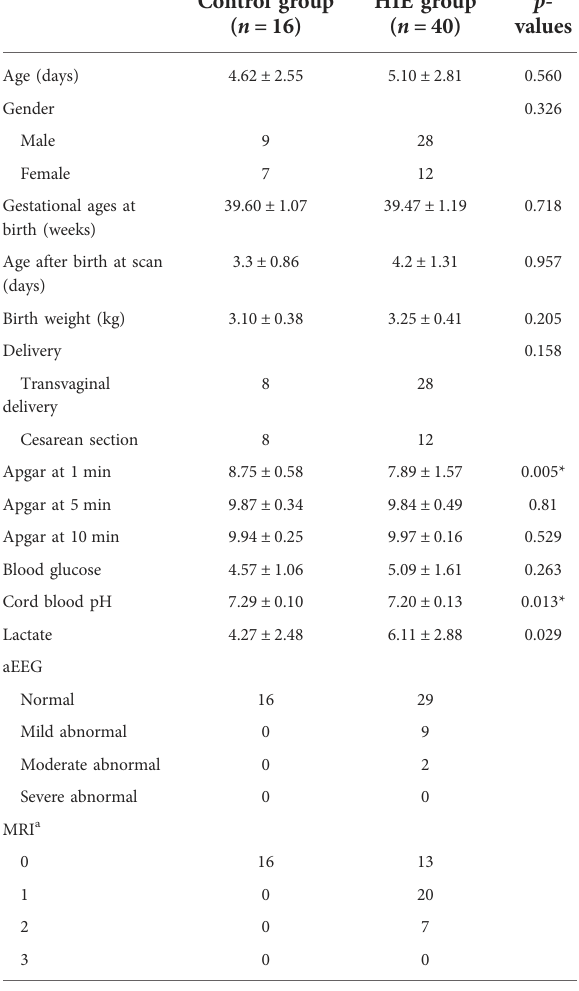
TABLE 1 Demographic and clinical characteristics of neonates with HIE and controls.